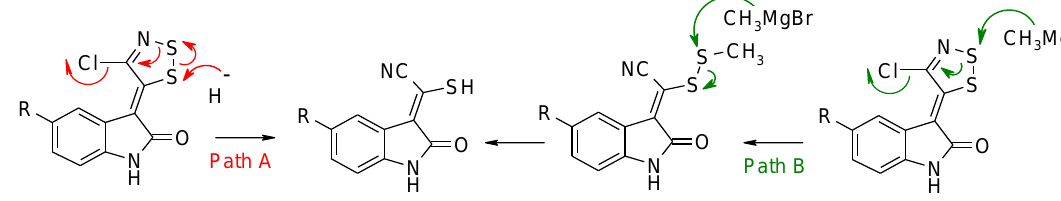
Table 3. 1 H-NMR data δ of H4 (in ppm) of the mercaptoacetonitriles ( 4a – 4d ) and the disulfur dimers ( 5a – 5c